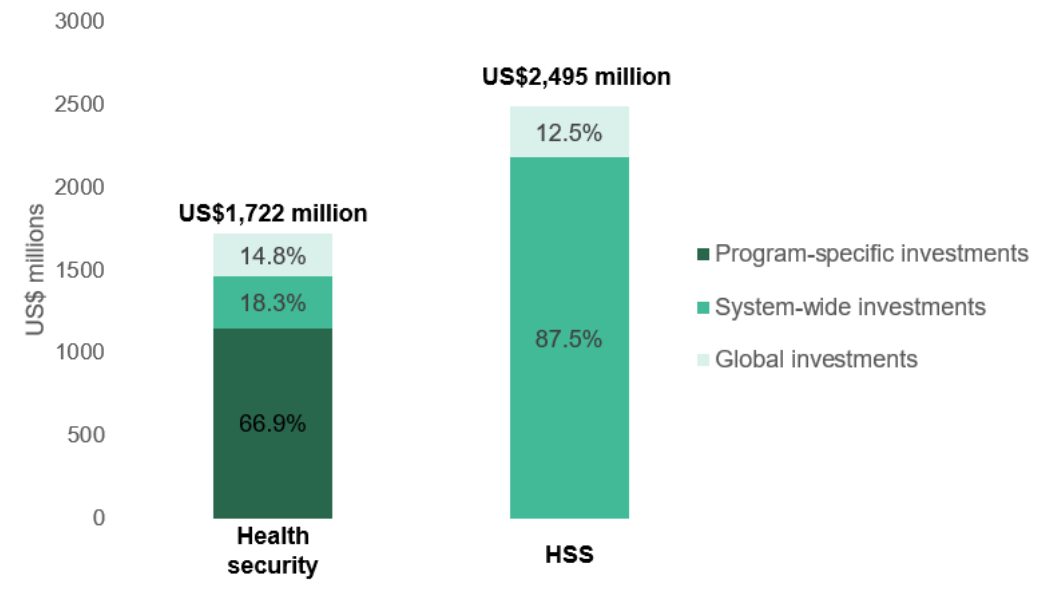
Figure 5. Distribution of development assistance for health for health security and health systems strengthening (HSS) across three major